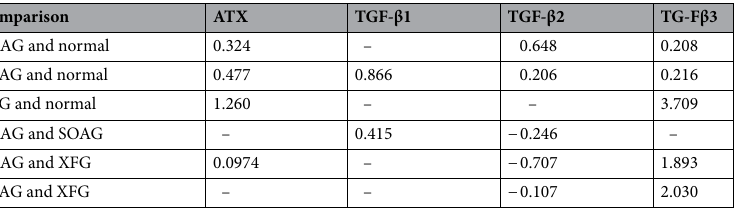
Table 3. Coefficients of the LASSO regression models after normalizing ATX, TGF-β1, TGF-β2, and TGF- β3 values. POAG: primary open angle glaucoma, SOAG: secondary open angle glaucoma, XFG: Exfoliation glaucoma, LASSO: Least absolute shrinkage and selection operator, ATX: autotaxin, TGF-β: transforming growth